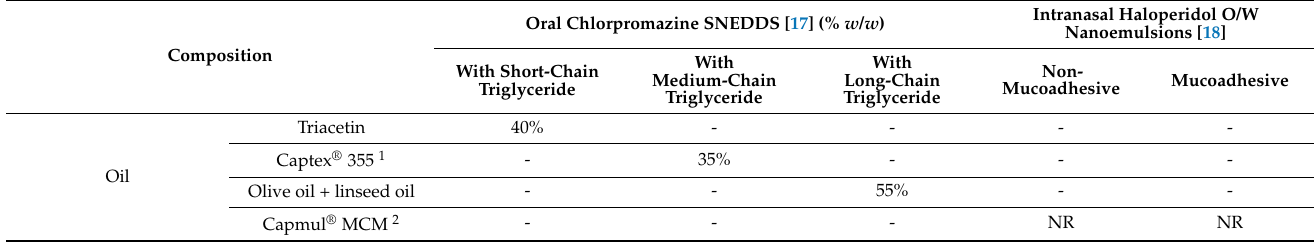
Table 2. Detailed composition of chlorpromazine and haloperidol nanometric emulsions. Excipient and drug quantities and units are shown as reported in the respective articles ( w / w % for excipients, and w / w % or mg/mL for drugs). For the excipients the brand name was used (when